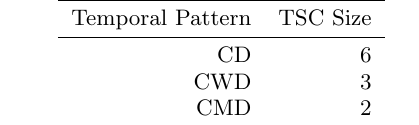
Figure 8: Probabilities for three consecutive periods Table 2: TSC size with exceptional distribution